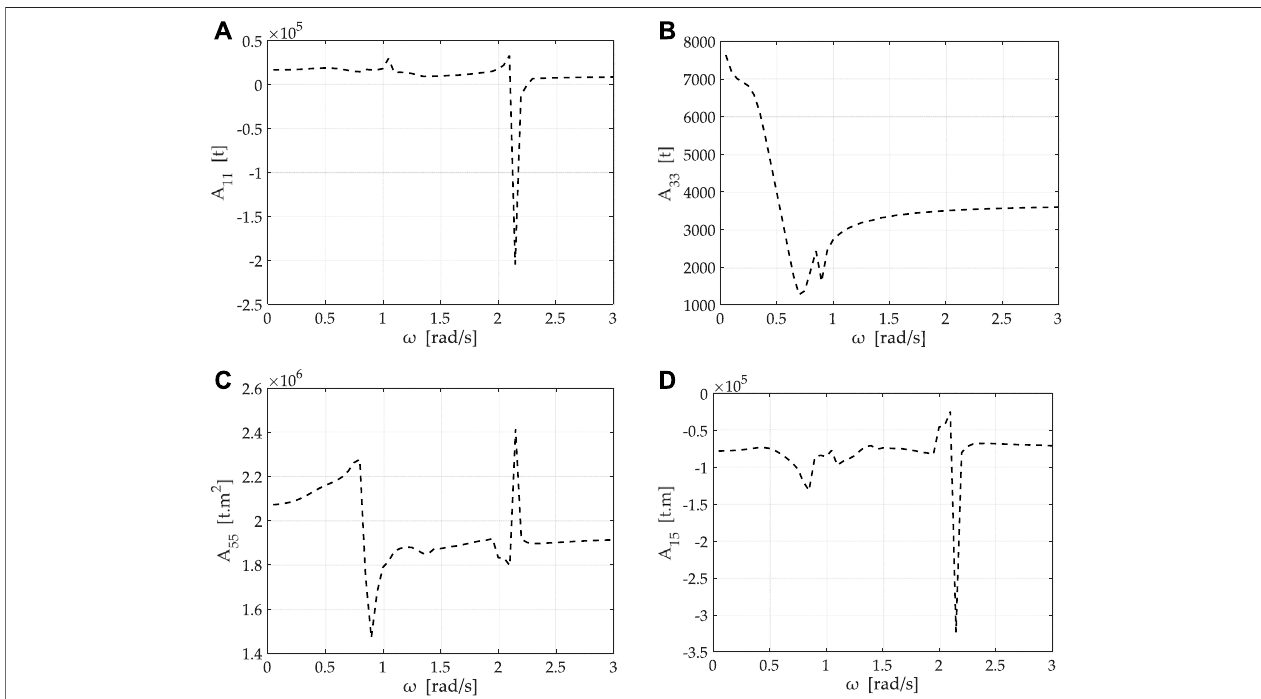
FIGURE 6 | Added mass coef fi cients of the hybrid structure versus wave frequency: (A) A 11 , (B) A 33 , (C) A 55 , (D) A 15 .